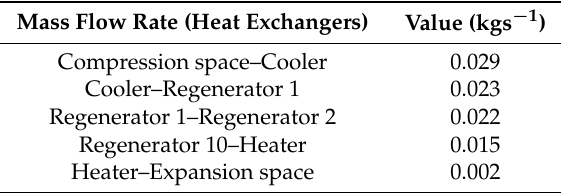
Table 5. Mass flow rate in the heat